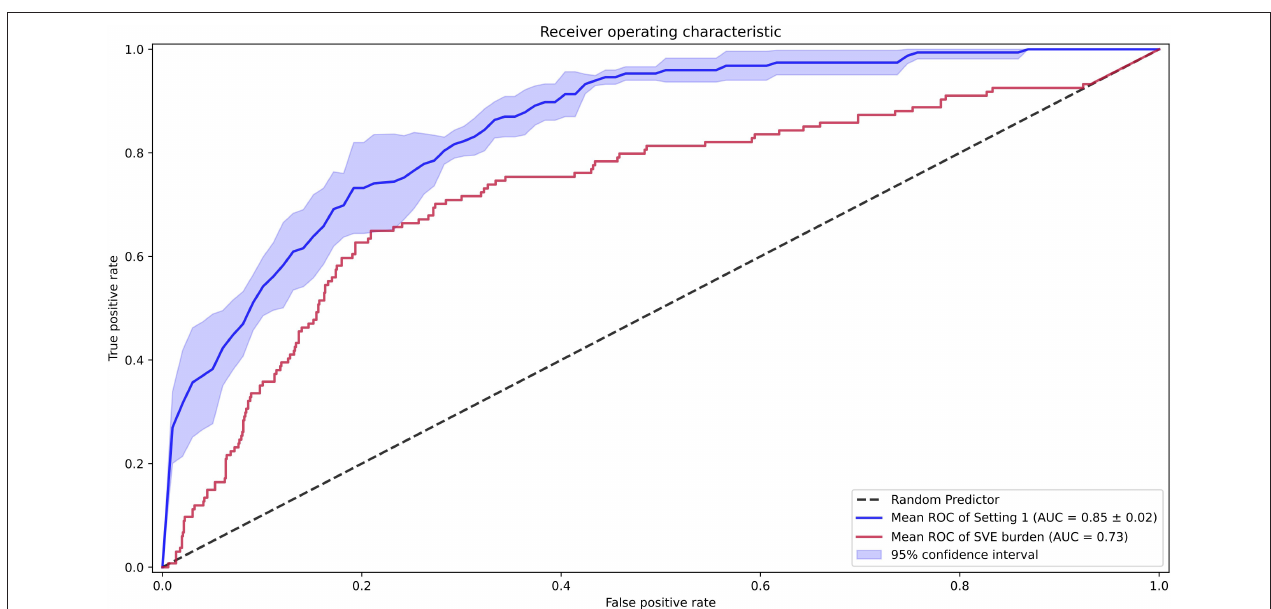
FIGURE 5 | Receiver operating characteristic curves for the performance of the artificial intelligence model [setting 1 including supraventricular ectopy (SVE)], and SVE burden for Holter annotation.